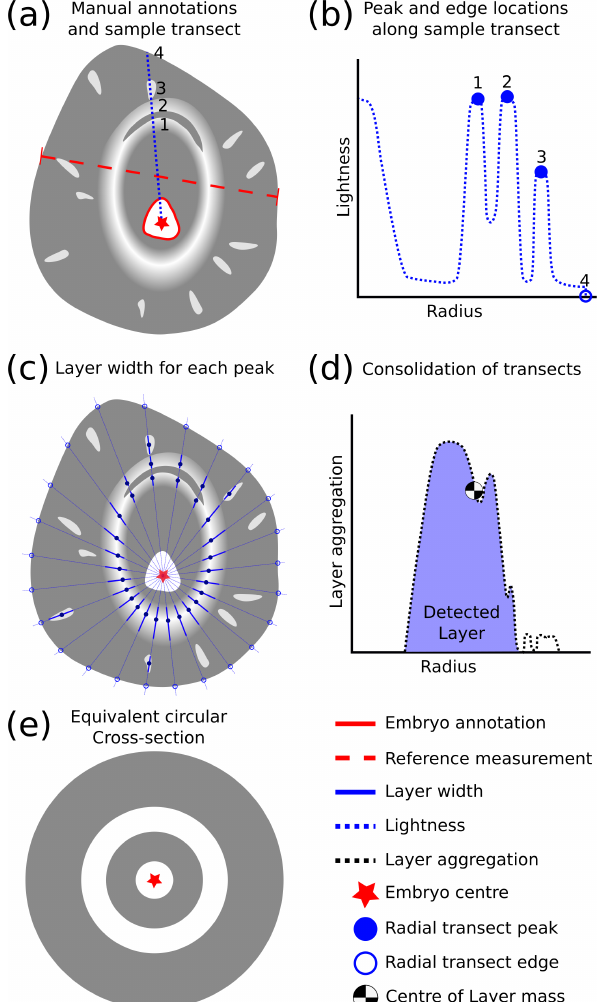
Figure 3. Conceptual diagram of analysis procedure: (a) manual annotations and sample transect with three peaks marked (1, 2 ,3) and the edge location (4). (b) Representation of transect in radius– lightness space with peaks and edge marked from (a) . (c) Mea- surement of layer width for each peak detected. (d) Detected layer centre of mass from consolidated transect analysis. (e) Equivalent circular hailstone cross section where wet and dry growth is repre- sented by grey and white shading,